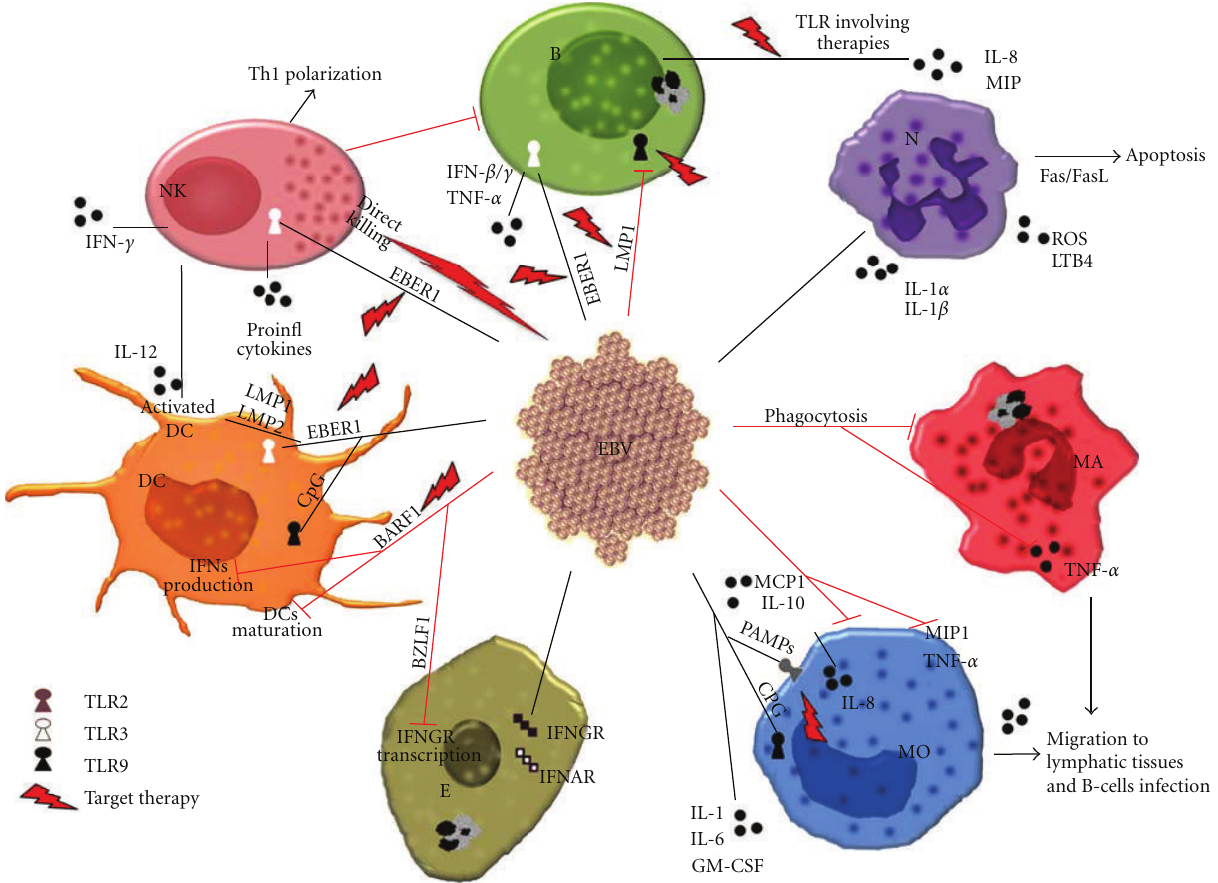
Figure 1: Interplay between EBV and innate immunity e ff ectors. Main activating (dark lines) and inhibitory (red lines) e ff ects of EBV infection on B lymphocytes (B), neutrophils (N), macrophages (MA), monocytes (MO), epithelial (E), dendritic (DC), and natural killer (NK) cells. Potential sites of intervention of targeted therapy approaches are also suggested (arrows). For further insights see